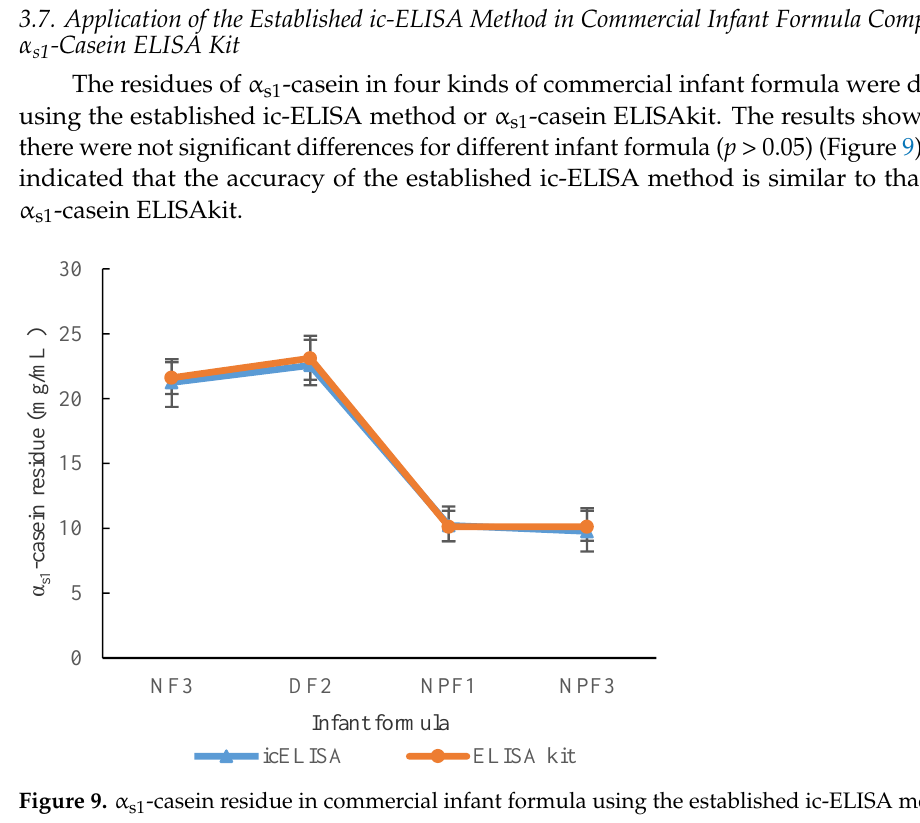
Figure 8. Degree of hydrolysis of α s1 -casein against six different kinds of proteases. The different letters a-f indicate significant differences between different data.